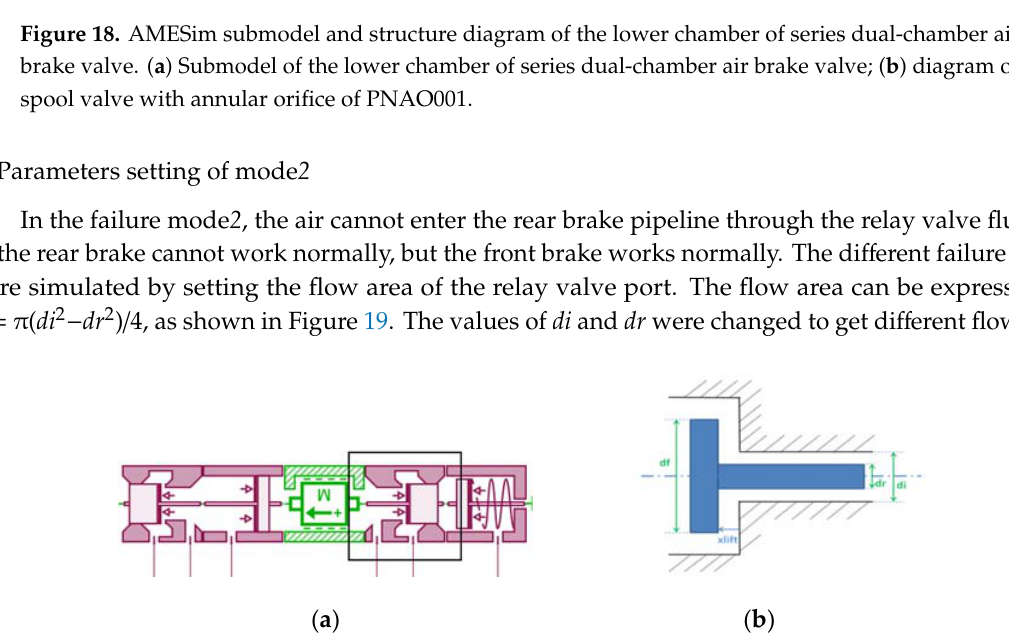
Figure 19. AMESim submodel of relay valve and structure diagram of the component PNAP031. ( a ) Submodel of the relay valve; ( b ) structure diagram of the component PNAP031.